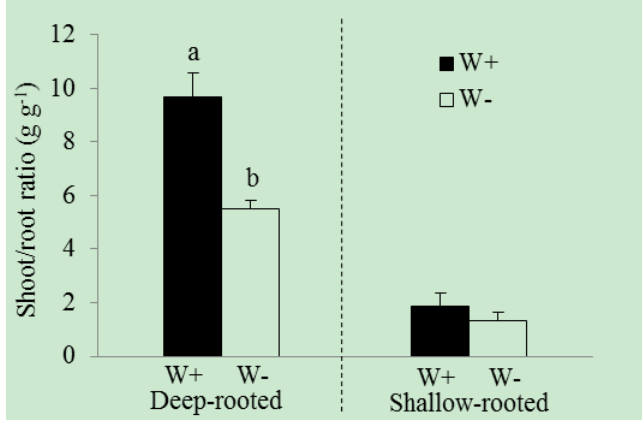
Figure 5. Mean values ± SE of shoot/root ration (g·g −1 ) of deep-rooted and shallow-rooted saplings growing in the field under different water availability treatments (W+ and W−). Data were obtained at the end of the second growing season (June 2012). Means with different letters indicate significant differences at p < 0.05 (Student’s t